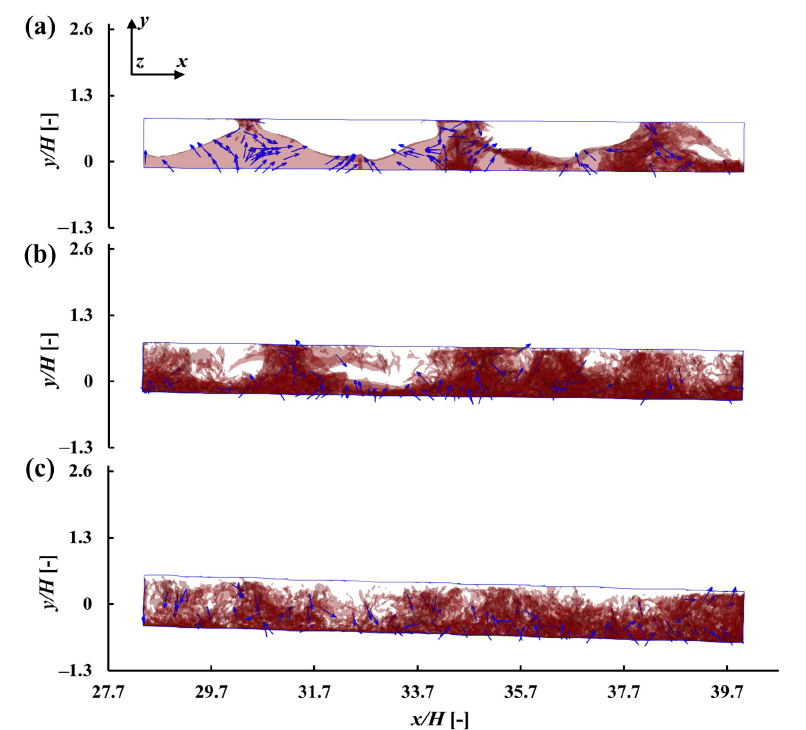
Figure 10. Snapshots for the sloshing tank with N c = 1 at t / T = 7.0 for ( a ) D i = 0.25, ( b ) D i = 0.5 and ( c ) D i = 1.0. Water phase is shown as transparent red with dark red representing the free surface. Blue arrows show the general direction of motion of the sloshing water.